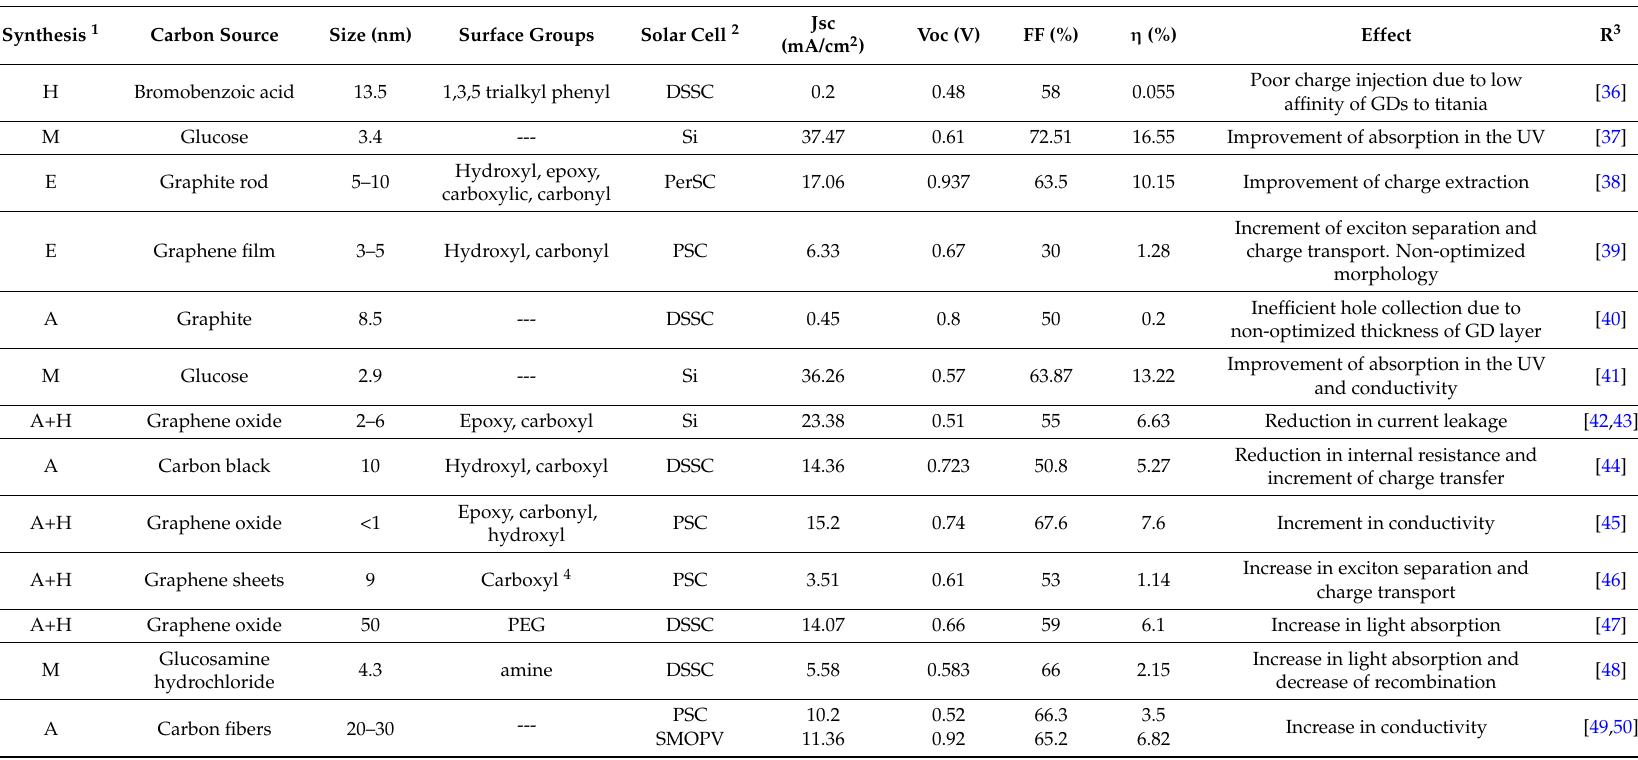
Table 2. Summary of the synthetic techniques of GDs included in this article, the resulting size and functional groups and the performance of the photovoltaic cells in which they are